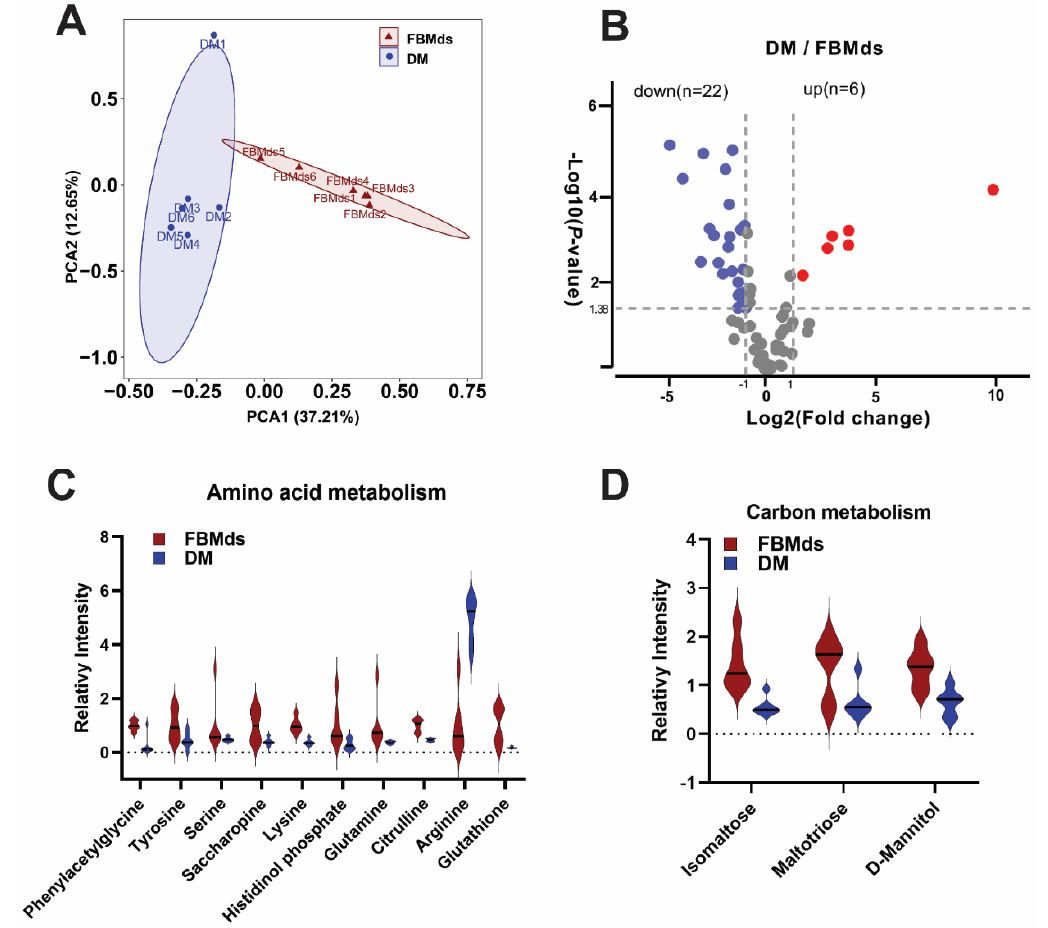
Figure 6. Comparative metabolism analysis of FBMds and DM. ( A ) Principal Components Analysis (PCA) plot of the metabolic signatures of FBMds and DM. ( B ) Volcano plot of the 75 known metabolites used for analyses. ( C , D ) Comparison of metabolites related to amino acids and carbohydrates between FBMds and DM, respectively.